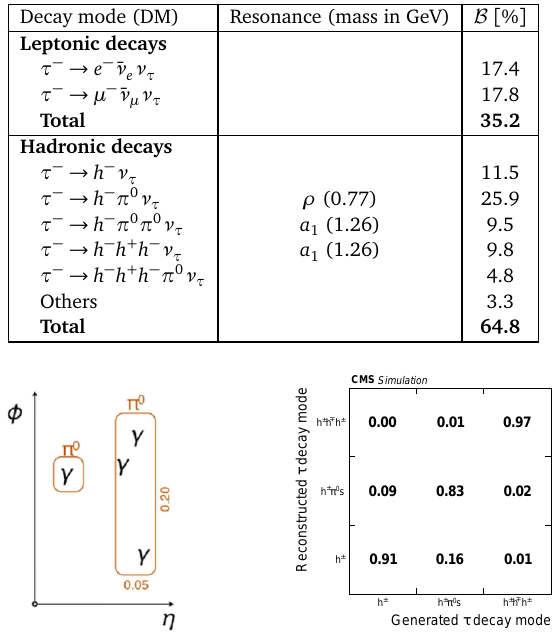
Figure 1: Left: A diagram showing the strip shape and size (Run-1) in the η × φ plane. Right: Correlation between generated and reconstructed τ τ decays in Z /γ ∗ → ττ events (Run-1) [ 2 ] h